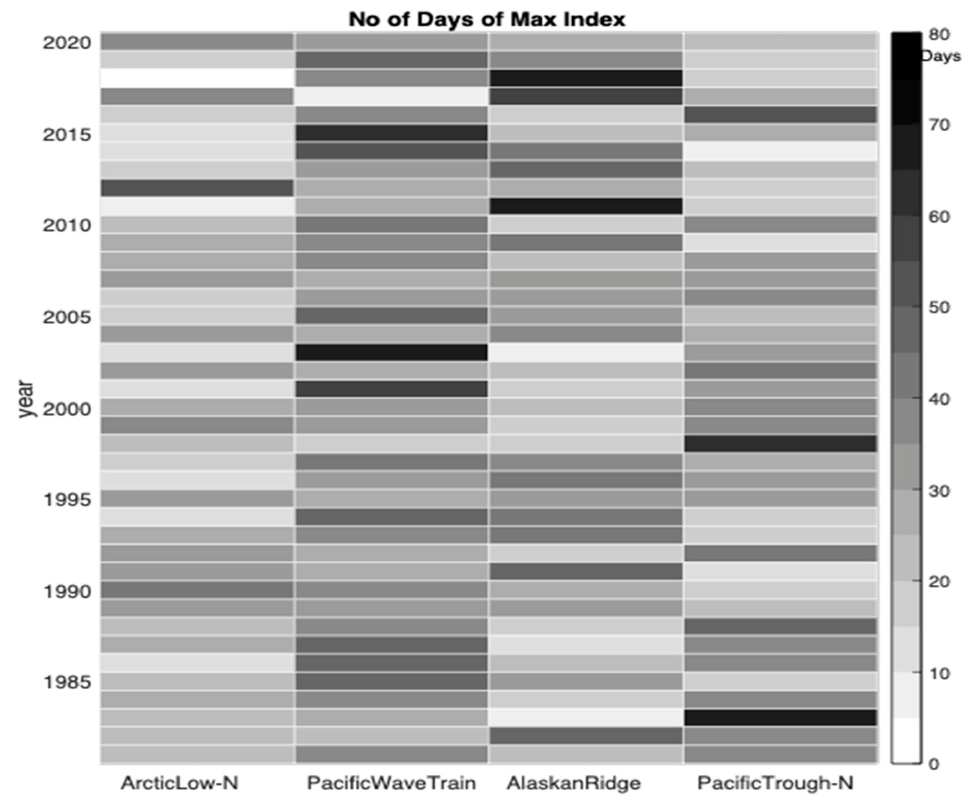
Figure 4. The number of days when each pattern takes a dominant role during the 4-month period in a given year. Among the 120 days in a given year, a pattern could be the strongest among the four patterns for ~80 days (black shading) or less than 5 days (white shading).